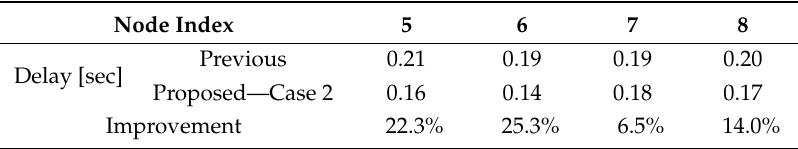
Figure 11. Downlink MAC level delay for each node in practical topology (40 Mbps offered load). Table 6. Summarized delay values in target